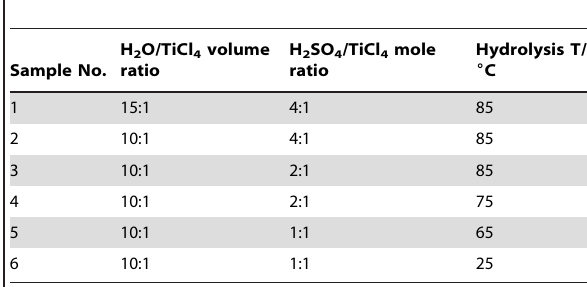
Table 1. The Comparison of Samples Prepared under Various Hydrolysis